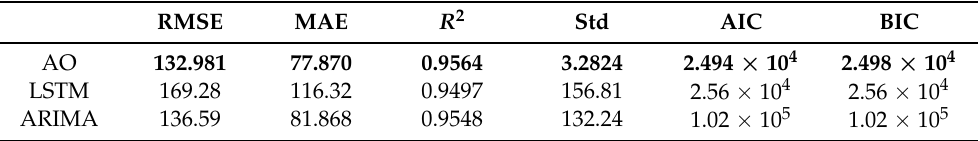
Table 7. The results of comparisons with other forecasting methods. The best values are shown in bold. RMSE